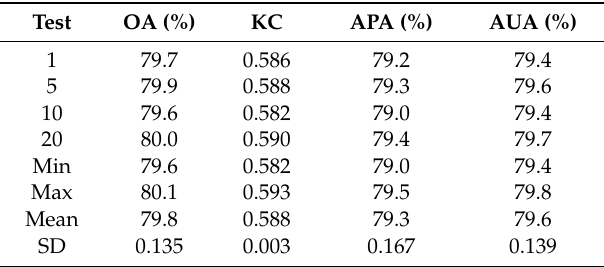
Figure 11. Accuracy of SAMENN-SUIM relating to normalized edge intensity index threshold (NEIIT) for Wuhan. ( a ) OA in relation to NEIIT. ( b ) KC in relation to NEIIT. ( c ) APA in relation to NEIIT. ( d ) AUA in relation to NEIIT. Table 2. Twenty repeated tests of SAMENN-SUIM for Wuhan.